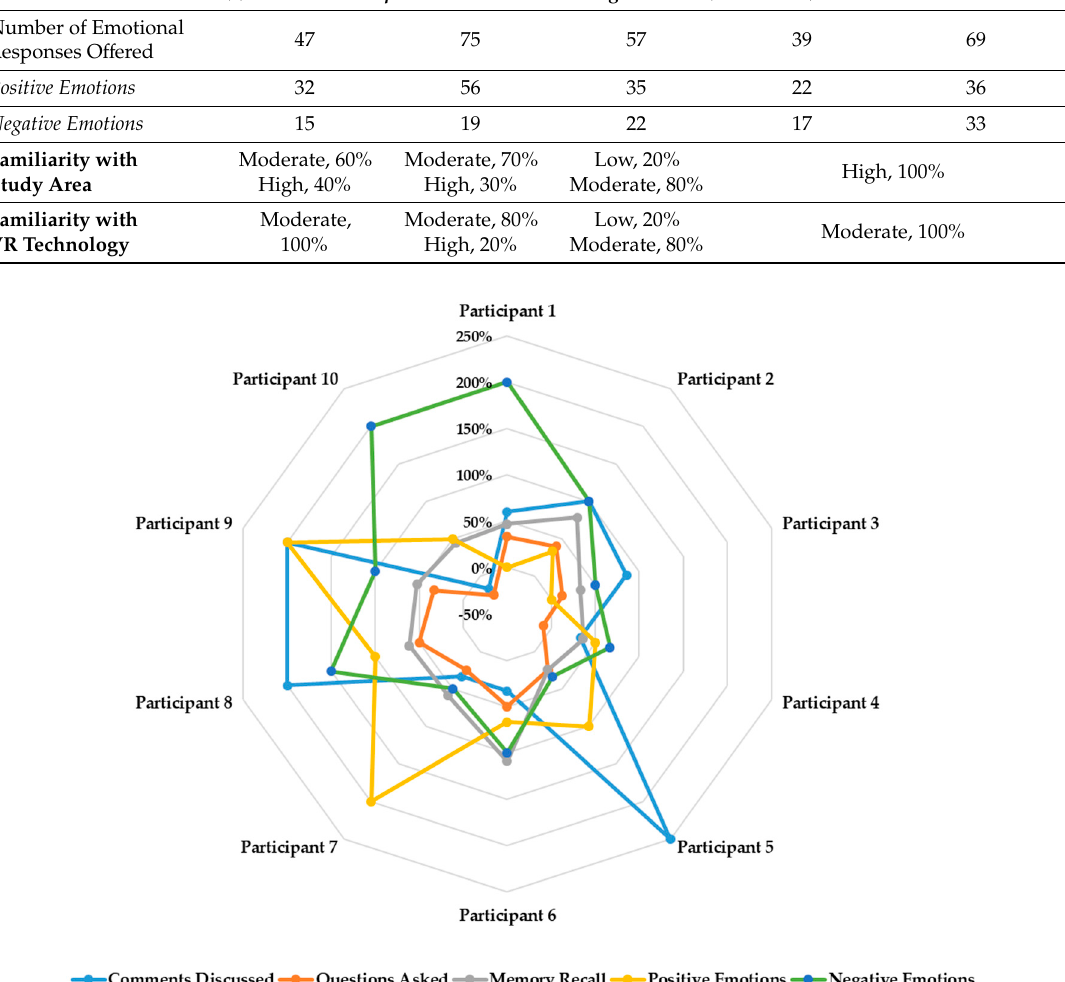
Figure 4. Percentage of change between two sessions among 10 members of Focus Group 4.